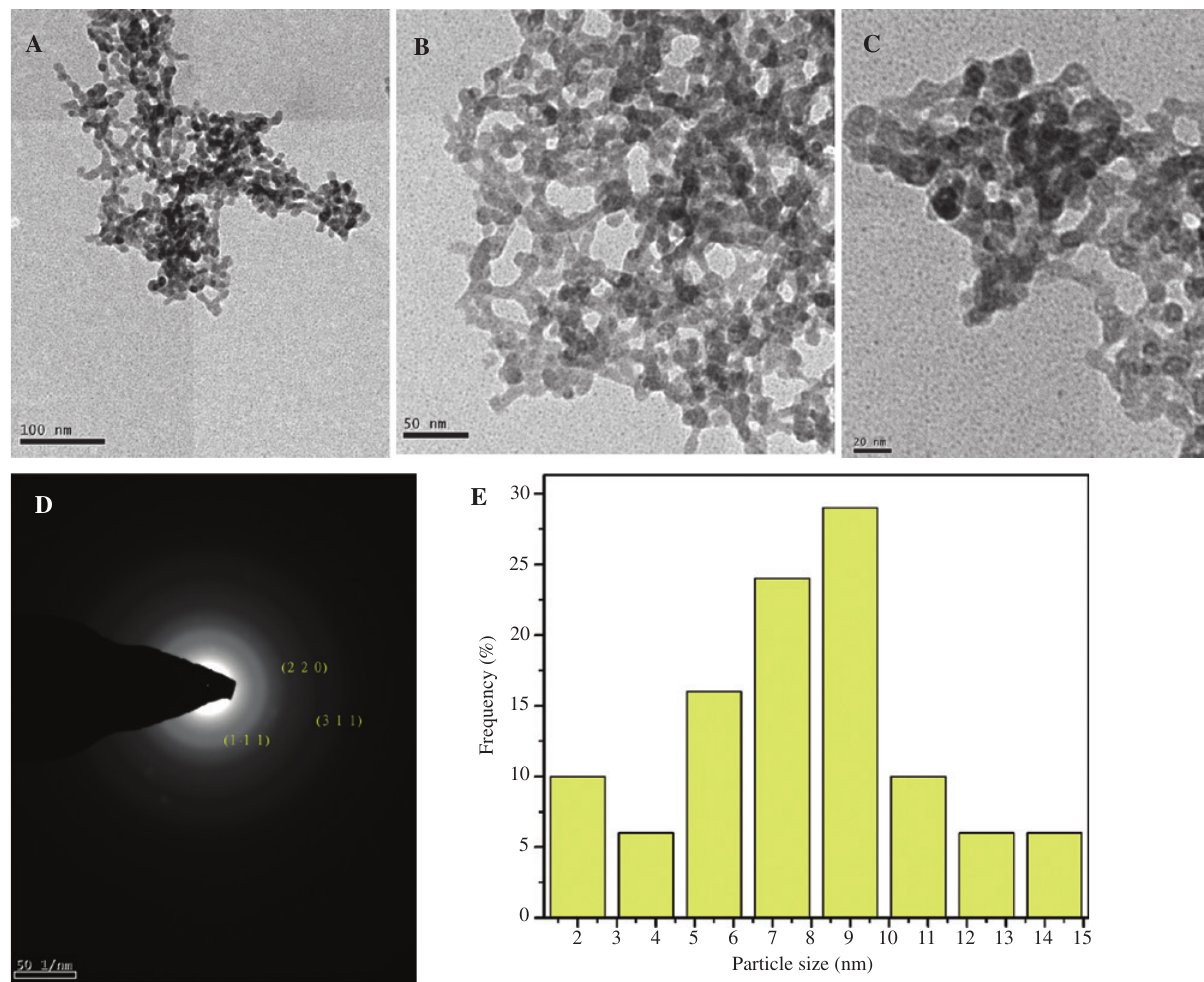
Figure 6: High-resolution transmission electron microscopy (HRTEM) images of zinc sulfide nanoparticles (A–C) from lower to higher magni- fications; SAED pattern (D); particle size distribution graphs